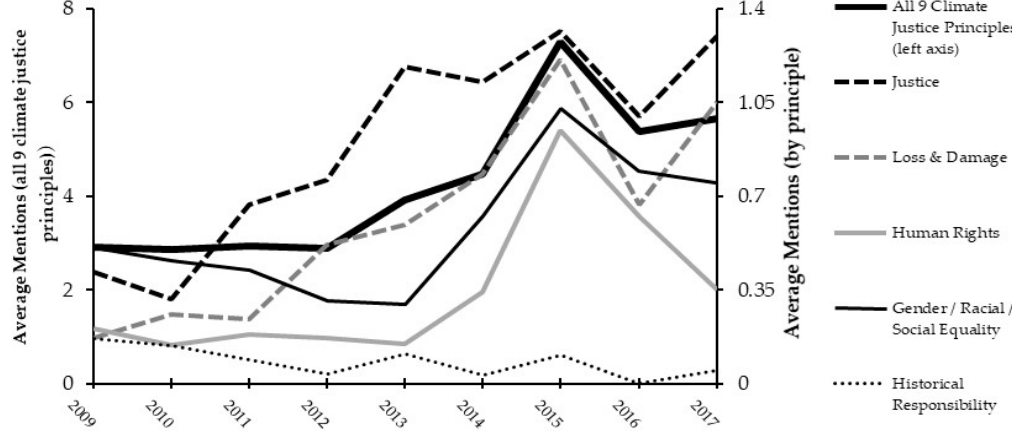
Figure 4. Climate Justice Mentions by Climate Action Network (CAN) (ECO Newsletter).